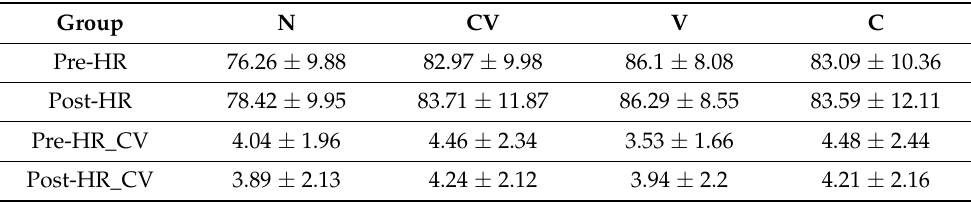
Figure 9. Results of pulse-variability score analysis of BPW indices for discrimination by excluding the data points located between the two thresholds. ( a ) Between Groups N (0; n = 28) and CV (1; n = 39). The two thresholds were 40 and 0.4. The excluded proportion was 34.33% (23/67). Accuracy = 72.72%, specificity = 0.57, sensitivity = 0.94, and AUC = 0.75. ( b ) Between Groups N (0; n = 28) and V (1; n = 11). The two thresholds were 17.1 and 0.4. The excluded proportion was around 35.90% (14/39). Accuracy = 92.00%, specificity = 1.00, sensitivity = 0.89, and AUC = 0.94. Table 5 indicates that there were no significant changes in HR and HR_CV in any of the four groups. Table 5. No significant changes in HR (in beats/minute) and HR_CV (in %) were found in any of the four groups.